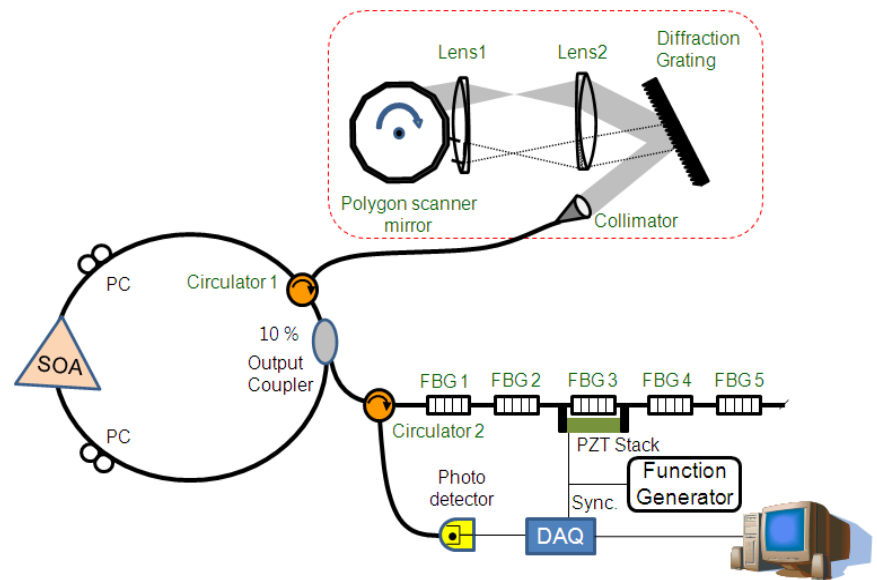
Figure 1. Schematic diagram of the experimental